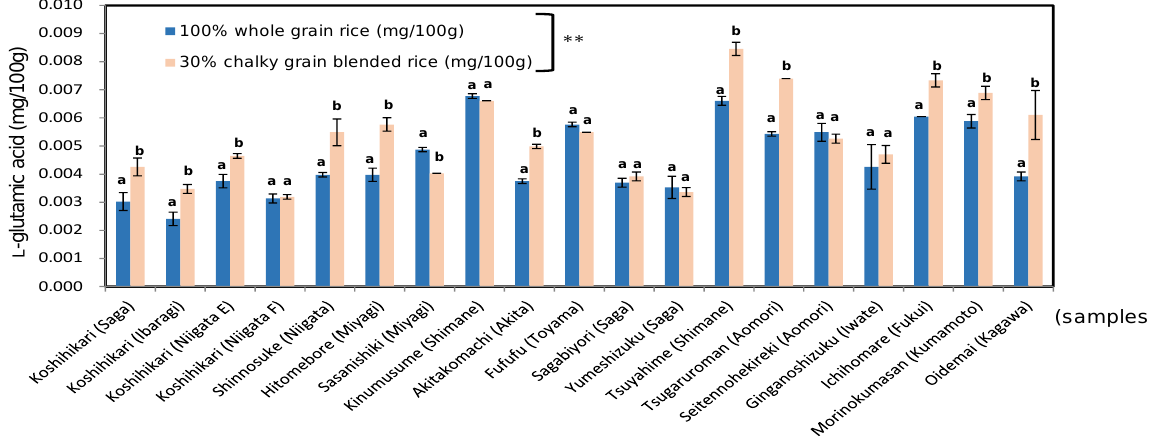
Figure 7. L -glutamic acid of 100% whole rice boiled grains and 30% chalky rice blended grains in 19 kinds of Japonica rice in 2020. Different letters (a, b) mean that whole and 30% chalky grains in each same rice samples are significantly different. ** Correlation is significant at 1% by the method of Tukey’s multiple comparison.